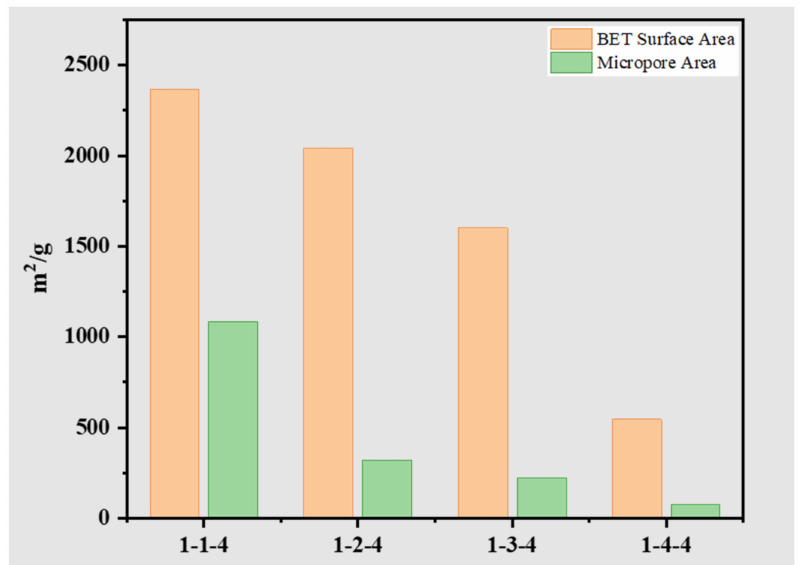
Figure 2. Surface area and different textile–phosphoric acid–distilled water ratios (Adapted from Wesley, et al. [25]. Reproduced with permission from